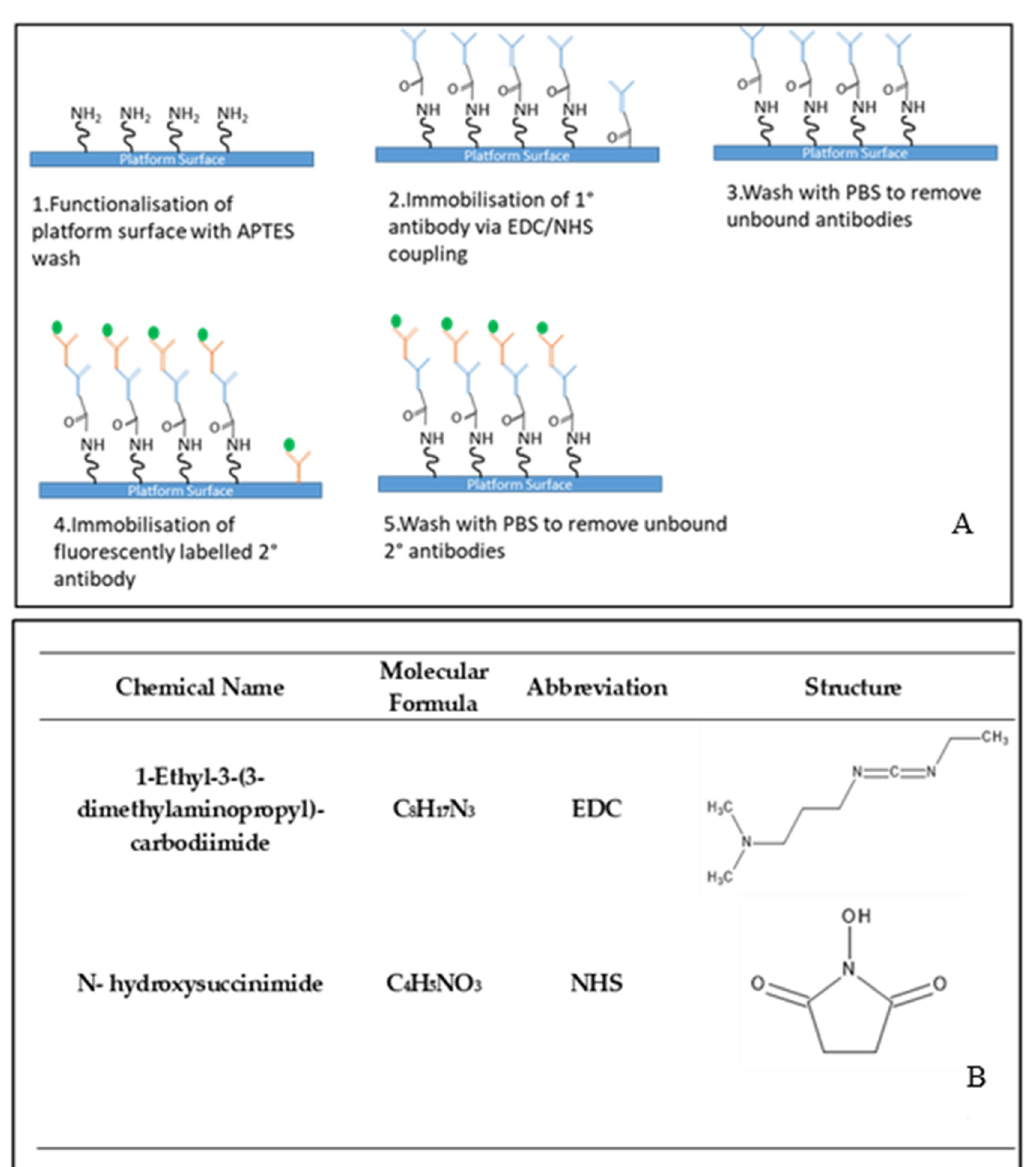
Figure 4. Representation of the biotechnological protocol employed in the sensing testing of the optofluidic device ( A ) and chemical name, molecular formula, common abbreviation and structure of the coupling agents used ( B ).